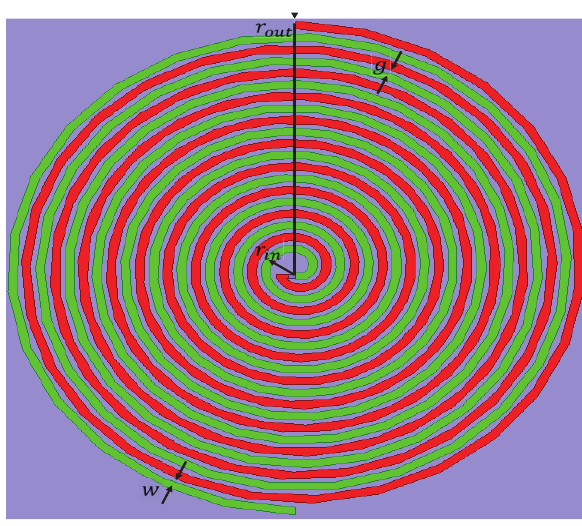
Figure 2. Layout of the antenna structure.